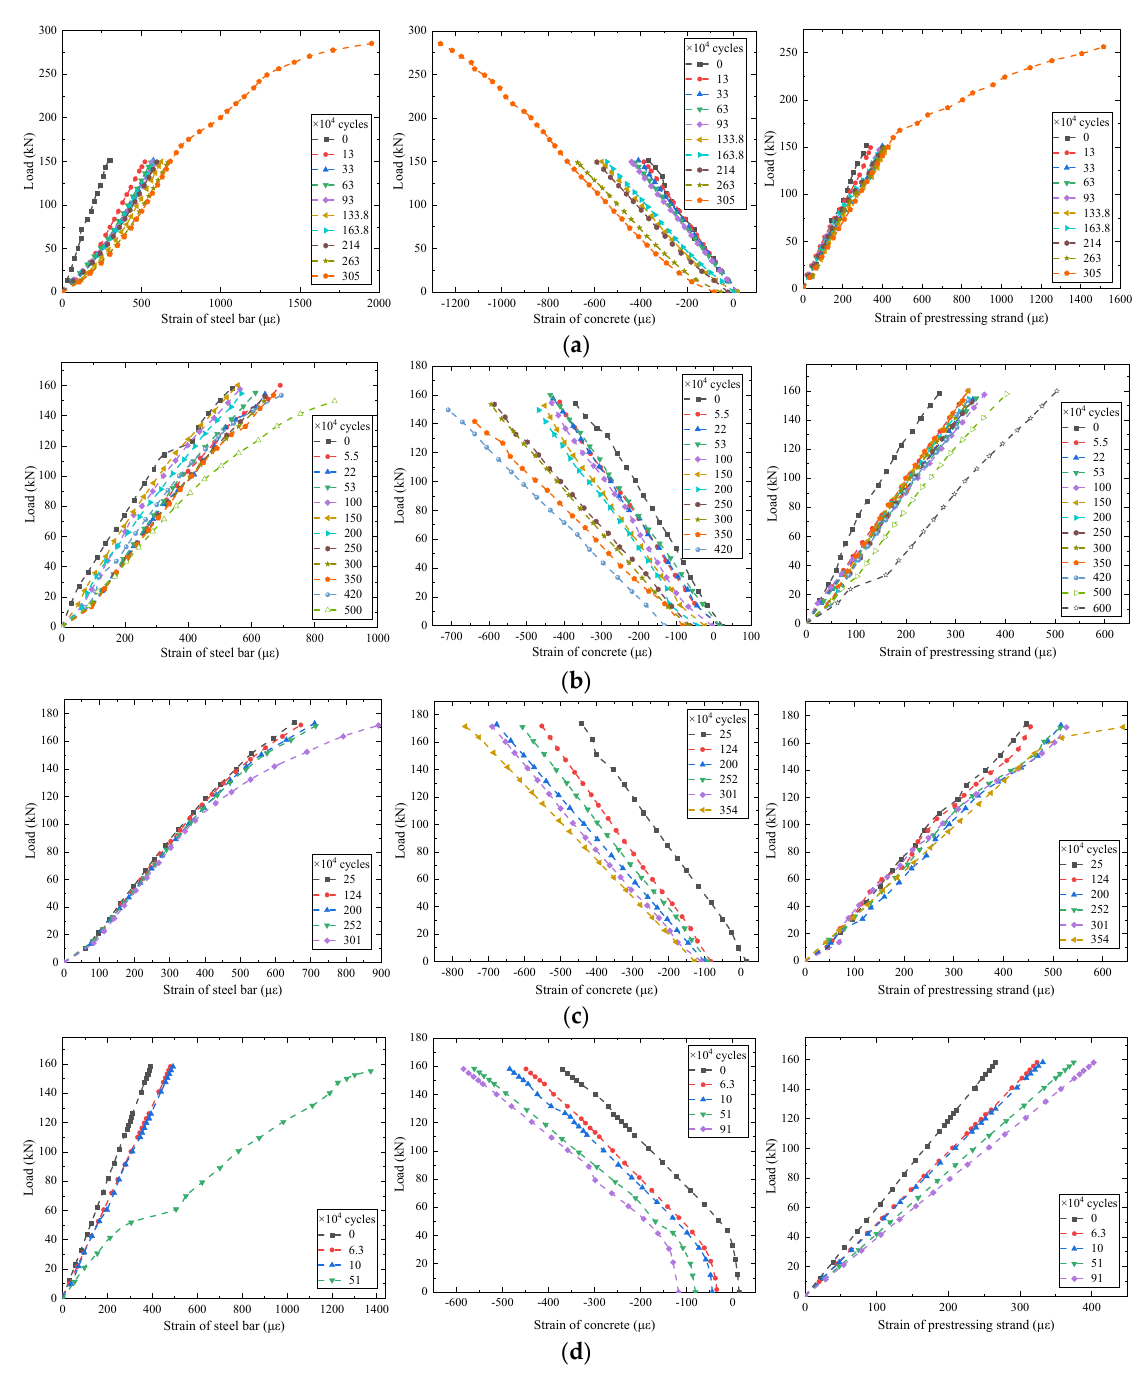
Figure 12. Strain development of concrete, steel bar, and prestressing strand under constant-amplitude fatigue loading: ( a ) The test beam C1; ( b ) The test beam C2; ( c ) The test beam C3; ( d ) The test beam C4.